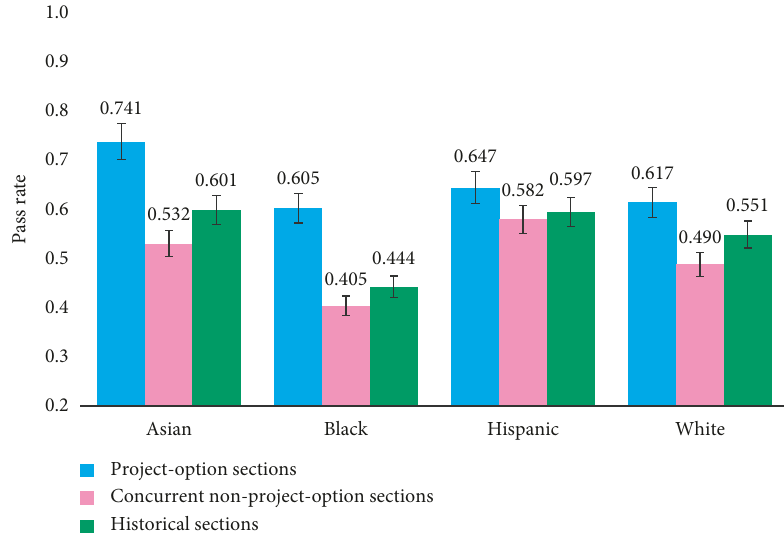
Figure 5: Mean pass rates and 95% confidence intervals for Engineering Calculus II by race/ethnicity